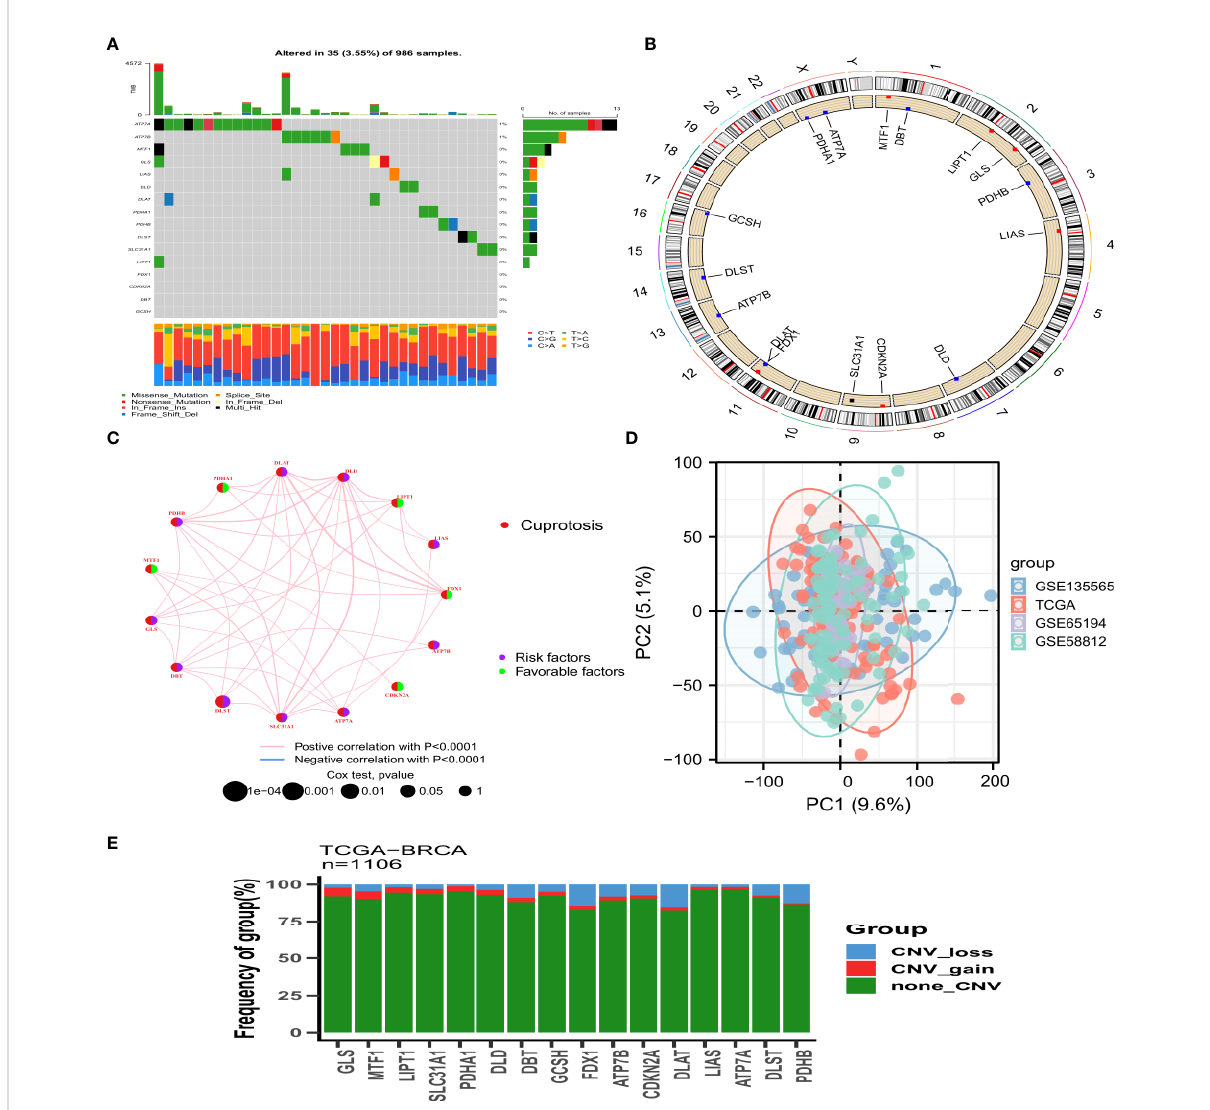
FIGURE 1 Landscape of genetic variation of Cuprotosis related genes in BRCA (A) Mutation frequency of 16 CRGs in 986 BRCA from TCGA and GEO combined samples. The number on the right indicated the mutation frequency of each gene. The bar chart on the right showed the proportion of mutations. The stacked bar chart below shows the fraction of conversions. (B) The position of CRGs CNV changes on 23 chromosomes. (C) Interaction between CRGs in BRCA. The line connecting CRGs indicated their interaction, and the thickness of the line indicated the correlation strength between CRGs. Purple and green represent negative and positive correlation respectively. (D) The fi gure of the PCA of the TCGA and GEO (GSE13356, GSE65194, GSE58812) datasets. (E) CNV mutation frequency of CRGs. The deletion frequency, blue dot; The ampli fi cation frequency, red dot. BRCA, breast cancer; CRGs, cuprotosis related genes; CNV, copy number